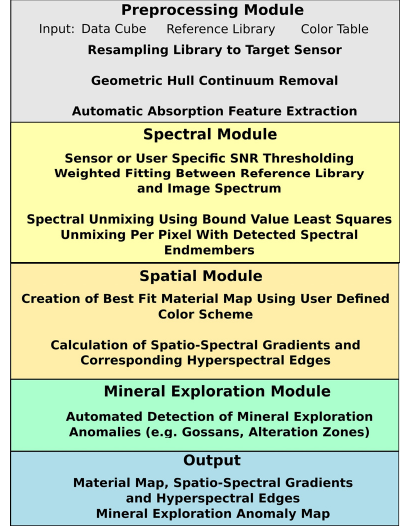
Figure 4. Modular processing workflow for mineral and material identification and characterization with EnGeoMAP 2.0.